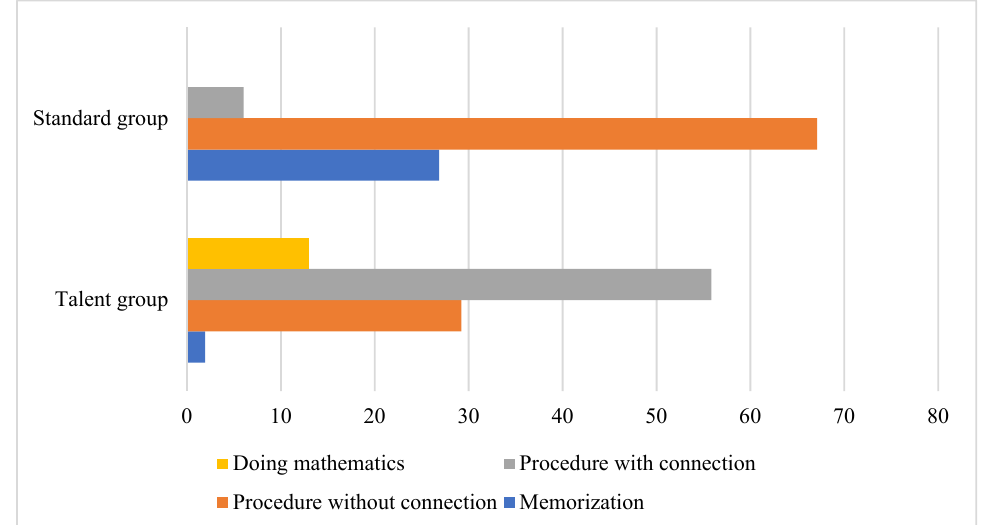
Figure 4. Cognitive demand. Percentage by group.